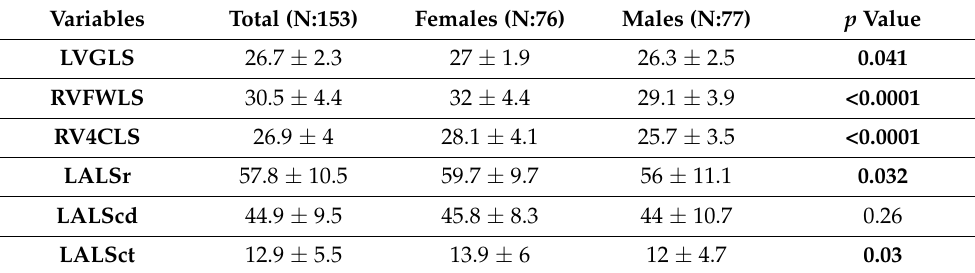
Table 4. Strain values categorized by sex.